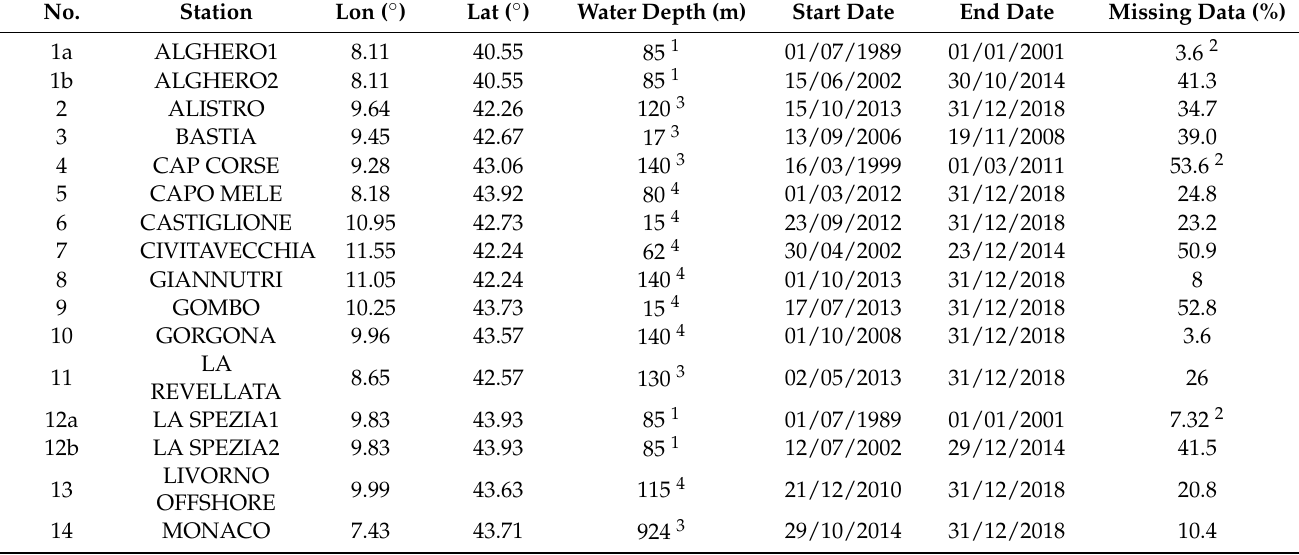
Table 3. Buoy stations with locations, water depths, time periods used to validate model data and percentages of gaps in the significant wave height (Hs) records. The wave direction was not available for buoy number 4.